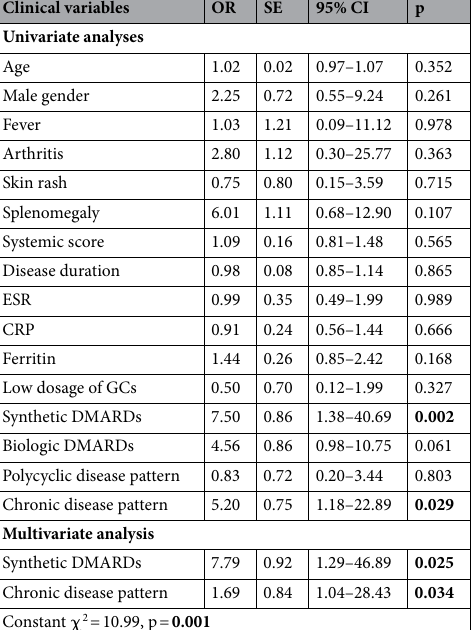
subset of patients showing MRI-bone erosions was characterised by a chronic disease course, lower levels of both ferritin and ESR. In addition, a global transcriptomic profile of synovial tissues suggested specific pathogenic pathways involved in AOSD joint involvement.